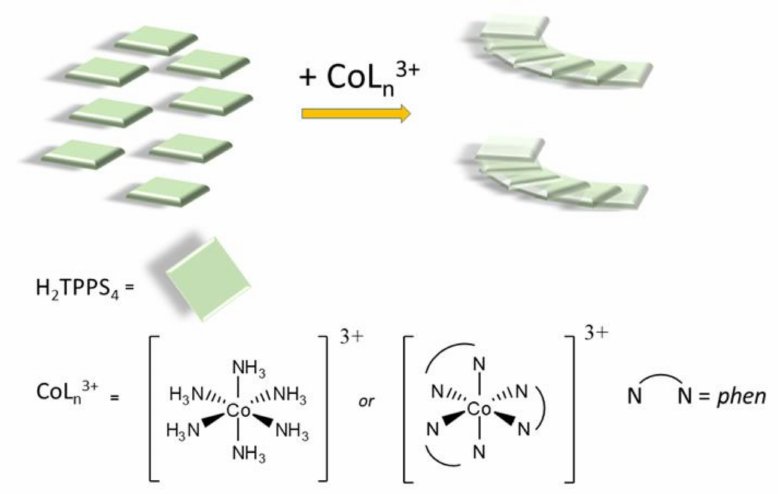
Scheme 1. Pictorial sketch of the self-aggregation process of the diacid H 2 TPPS 4 porphyrin into J-aggregates as induced by the cationic cobalt(III) complexes used in the present investigation.